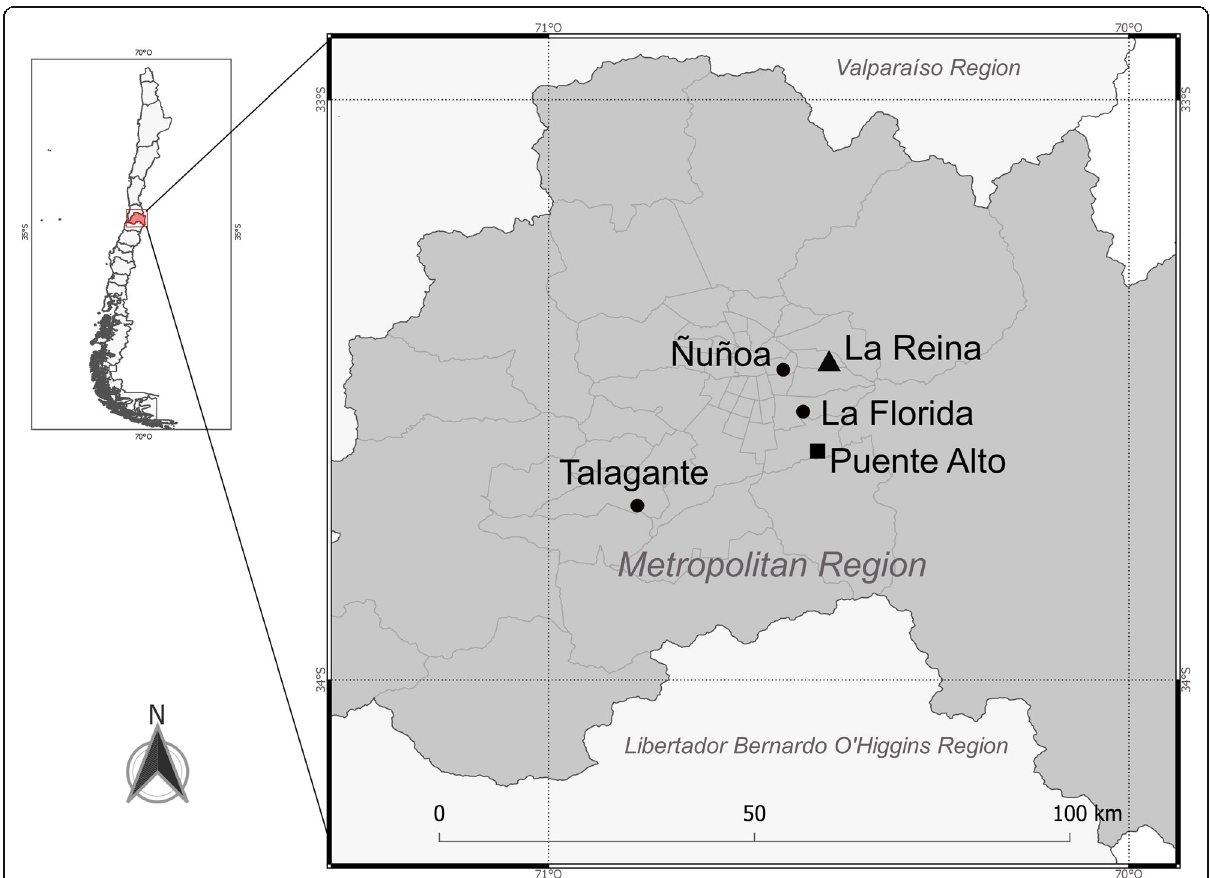
Fig. 2 Map showing the study sites in the Metropolitan Region where specimens were collected. In total, 13 campaigns were carried out. Parentheses indicate the number of visits to the same site: Ñuñoa (3), Puente Alto (2), La Florida (3), Talagante (3), and La Reina (2). Circles: sites where B. terrestris and X. augusti were collected; triangle: sites where only B. terrestris was collected; square: sites where only X. augusti was collected